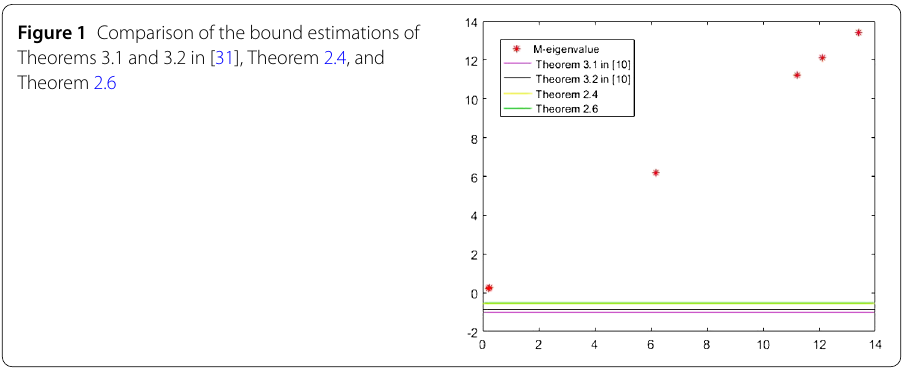
Figure 1 Comparison of the bound estimations of Theorems 3.1 and 3.2 in [31], Theorem 2.4, and Theorem